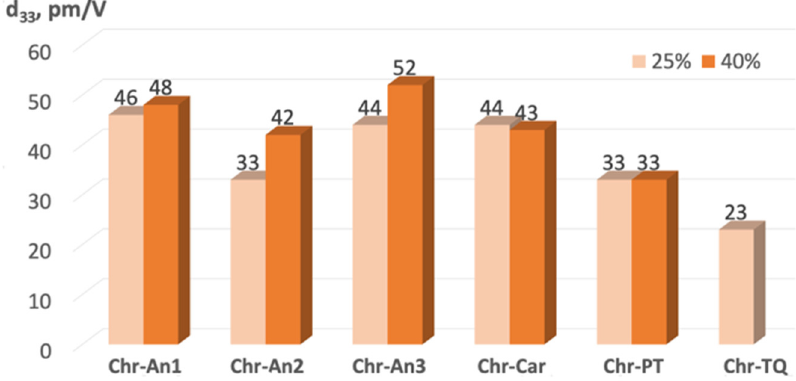
Figure 5. NLO coefficients of the composite materials with studied chromophores as guests. The dependences of the normalized SHG signal on the laser beam incidence angle for some composite polymer films are given in Figure 6.